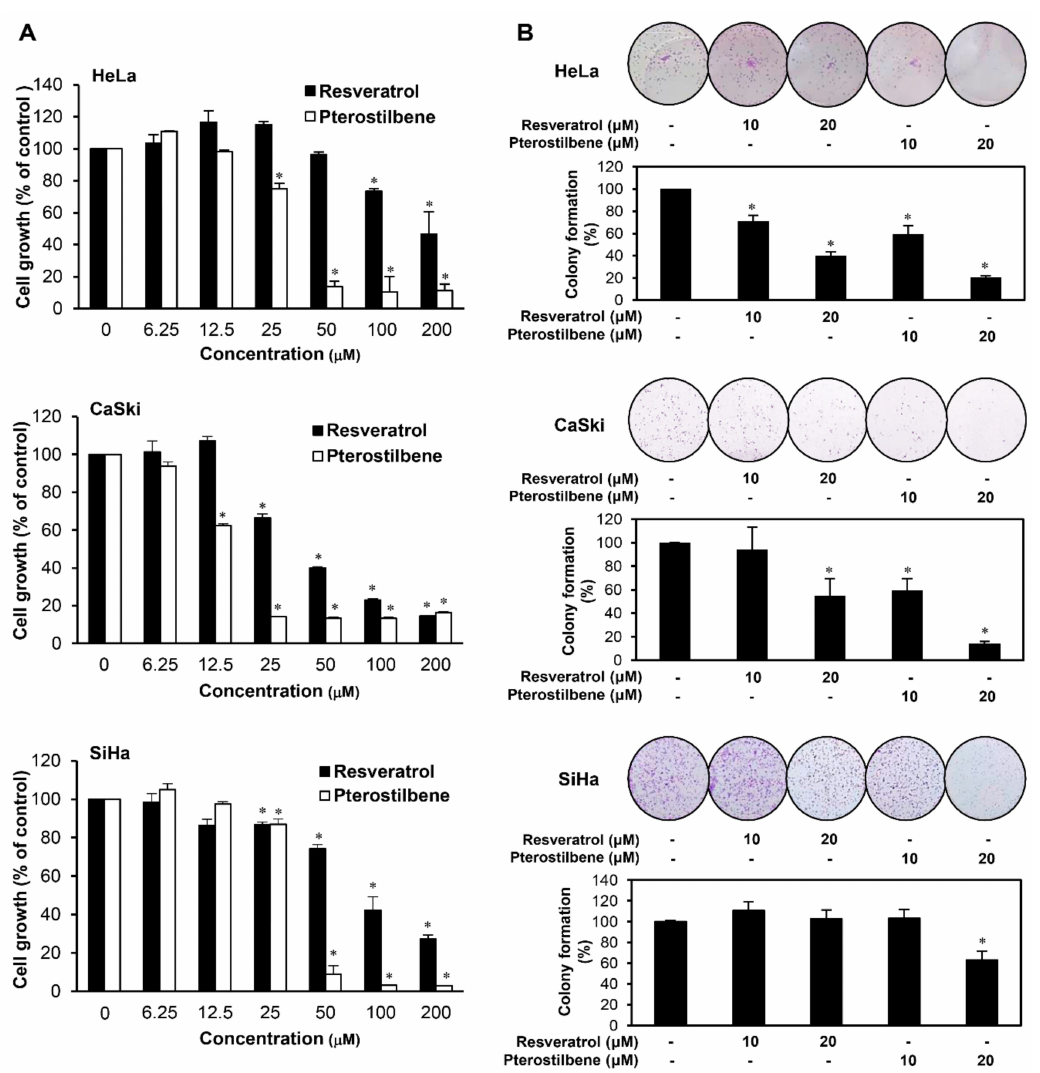
Figure 2. Growth inhibitory e ff ects of resveratrol and pterostilbene on HeLa, CaSki, and SiHa cells. ( A ) The e ff ects of resveratrol and pterostilbene on the growth of HeLa, CaSki, and SiHa adherent cells. The cells were treated with increasing concentrations of the two compounds (0–200 µ M) for 72 h, and cell growth was measured by 3-(4,5-dimethylthiazol-2-yl)-2,5-diphenyltetrazolium bromide (MTT) assay. ( B ) The e ff ects of resveratrol and pterostilbene on the colony forming ability of HeLa, CaSki, and SiHa adherent cells. The cells were incubated in the absence or presence of the two compounds (10 and 20 µ M) for seven days. The cell colonies were detected by crystal violet staining. * p < 0.05 versus the